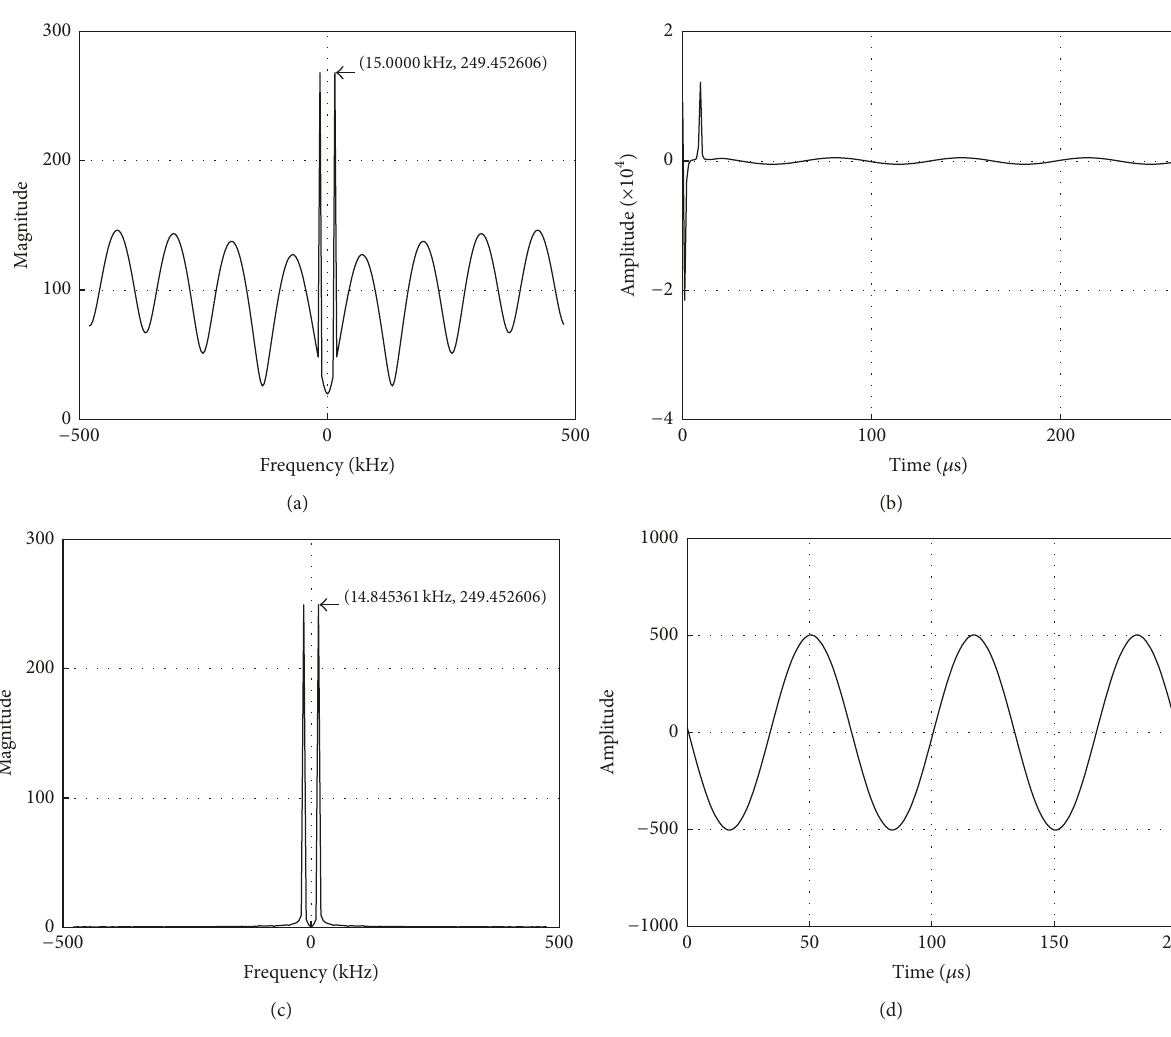
Figure 18: FM demodulator output showing the demodulated signal with transients and after removing the transients. (a) Magnitude spectrum of FM-demodulated signal, (b) FM-demodulated signal; (c) magnitude spectrum of FM-demodulated signal without transients, (d) FM-demodulated signal without transients.